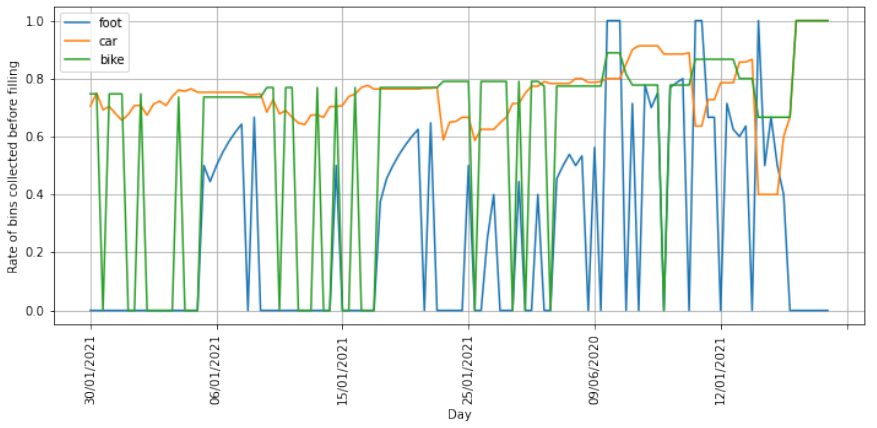
Figure 13. Collection rate per means of transport and